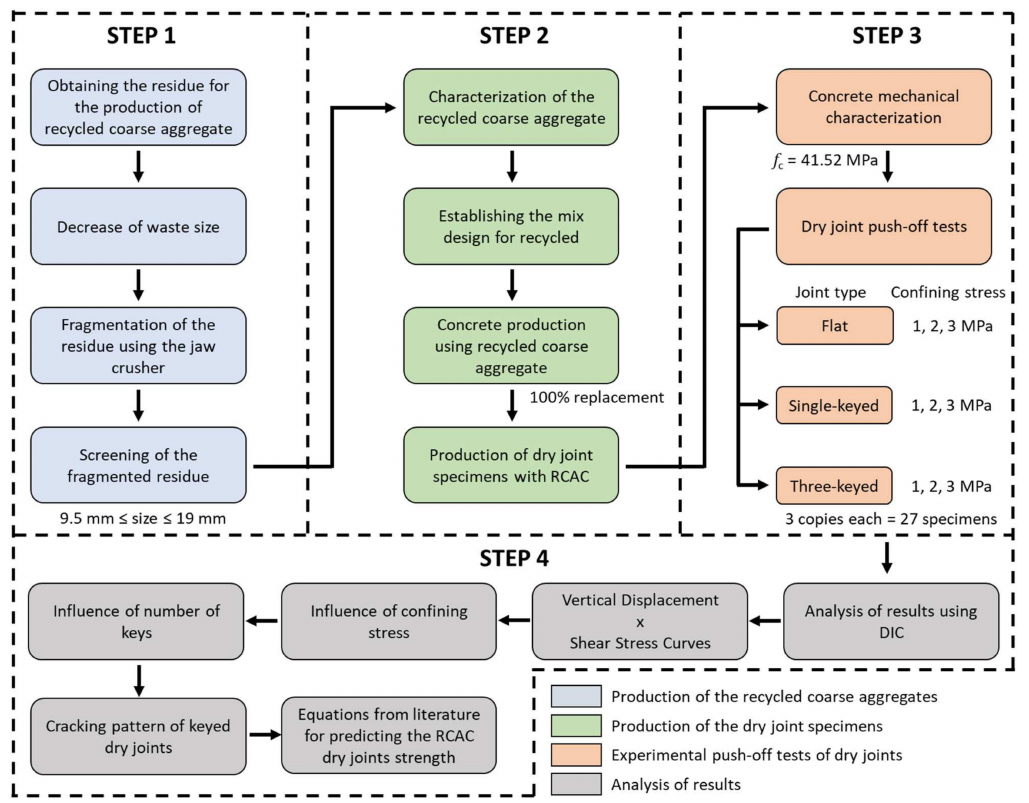
Figure 3. Flowchart of the adopted methodology.